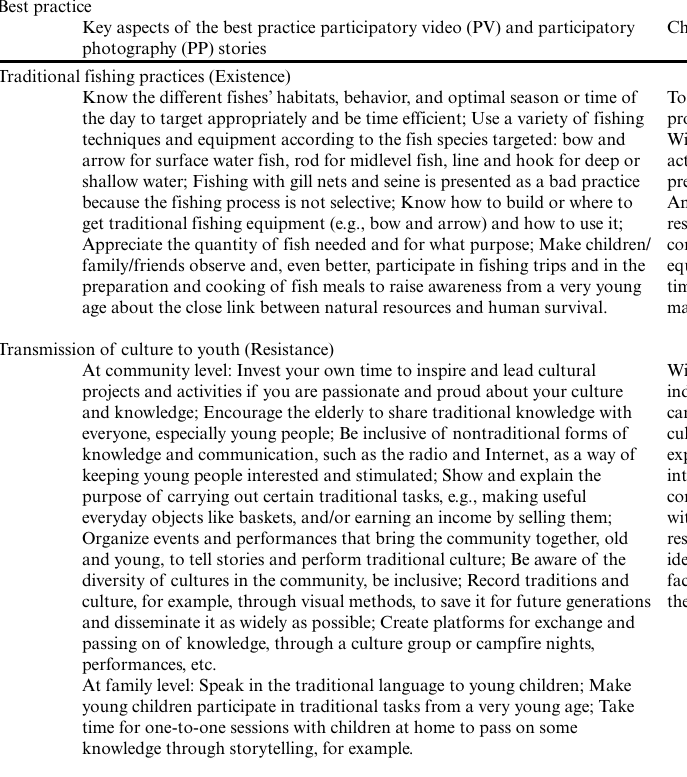
Table 2 . Short description of each best practice studied and associated